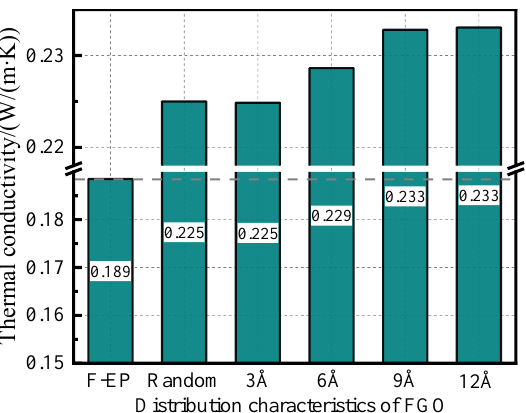
Figure 7. Thermal conductivity of FGO/F-EP composites with different distribution characteristics.